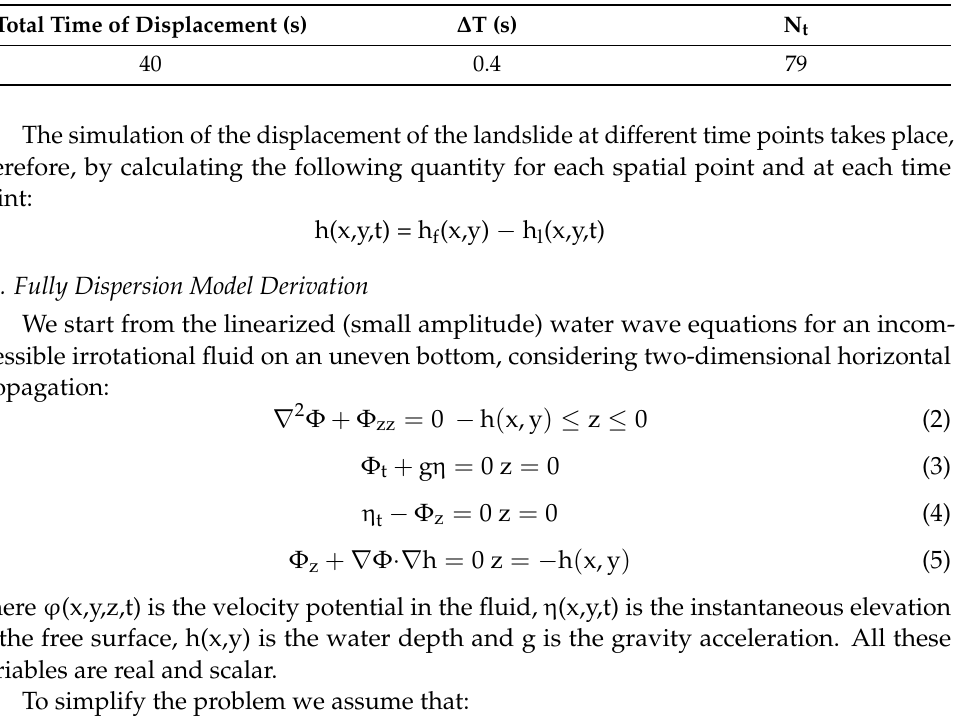
Table 4. Time features of the landslide displacement in its submerged